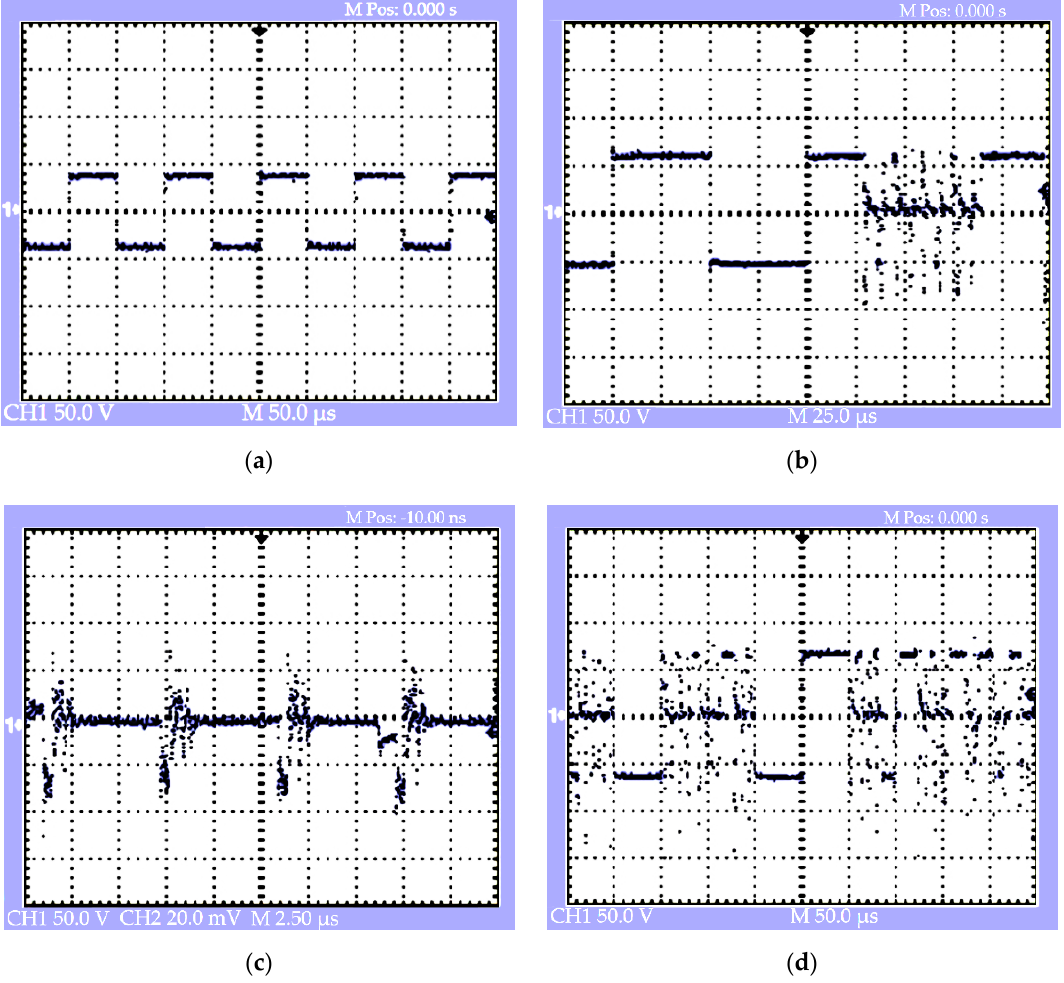
Figure 3. Electrical discharge machining pulses detected by the oscilloscope: ( a ) idle pules at a distance ∆ > ∆ DB ; ( b ) interrupted introduction of operational pulses at the distance ∆ ≥ ∆ DB ; ( c ) operational pulses during machining ∆ = ∆ DB ; ( d ) interrupted operational pulses during unstable wire feed and variation with the factors, ∆ ≈ ∆ DB .